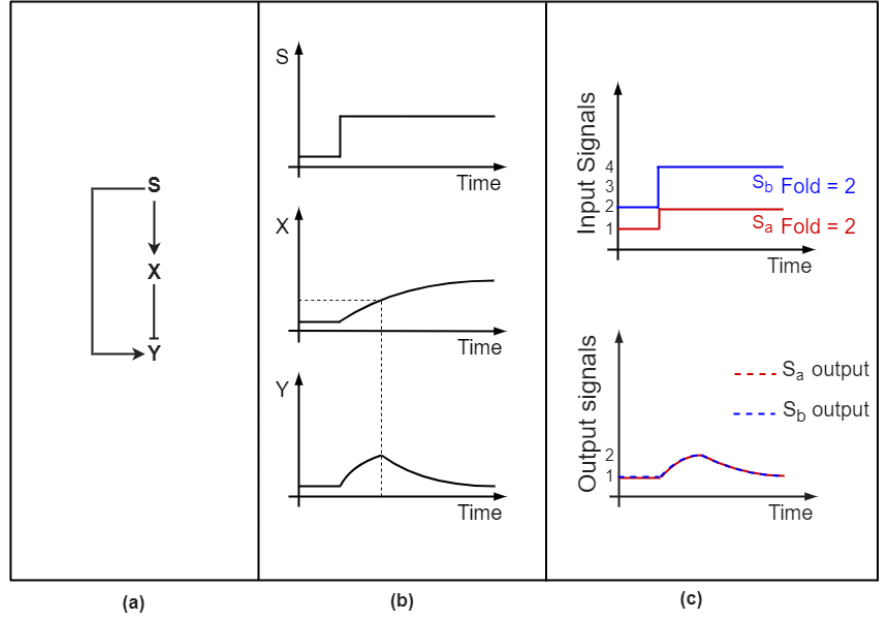
Figure 2. Representation of the incoherent type-1 feedforward loop (I1-FFL) and its signal-decoding properties. Edges with a pointed head represent positive (activatory) regulation, whereas edges with a flat head indicate negative (repressive) regulation. ( a ) I1-FFL: a master regulator S activates both a target output gene Y and a repressor X, which in turn targets Y. ( b ) Example of pulse-like response generation: a transient stimulus S induces the production of both X and Y. However, the output’s repression threshold is typically higher that its activation threshold. Thus, a Y increase is allowed until X reaches its threshold concentration (dashed line), leading the output’s level to drop. ( c ) Example of fold change detection: two input signals characterized by equal fold-change but different absolute levels lead to identical output